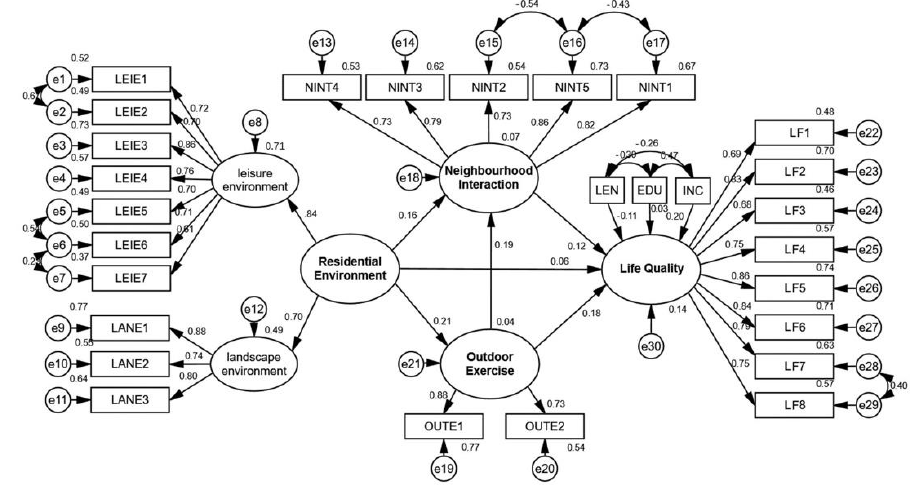
Figure 4. Standardized path diagram for the whole sample model.